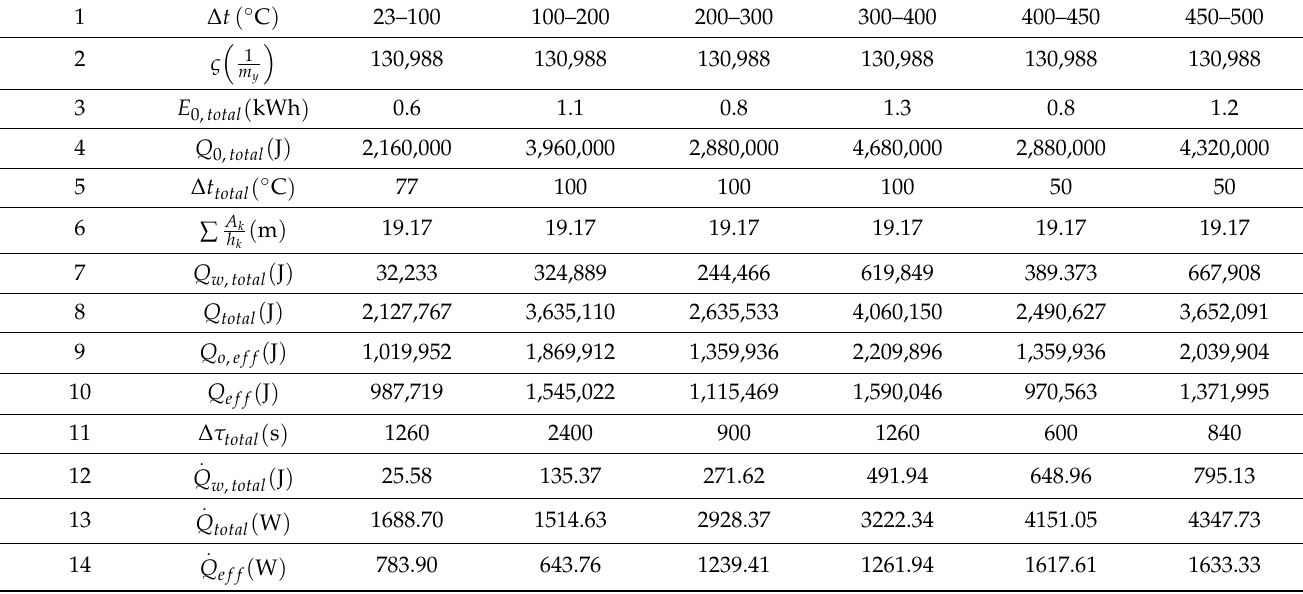
Table A2. Middle model, unpainted—scale